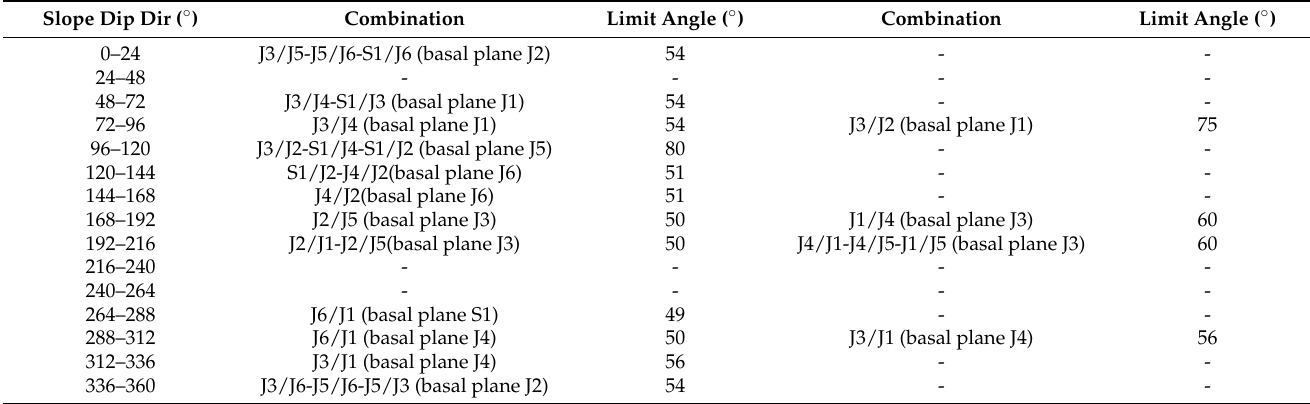
Table 8. Kinematic stability analysis results: direct